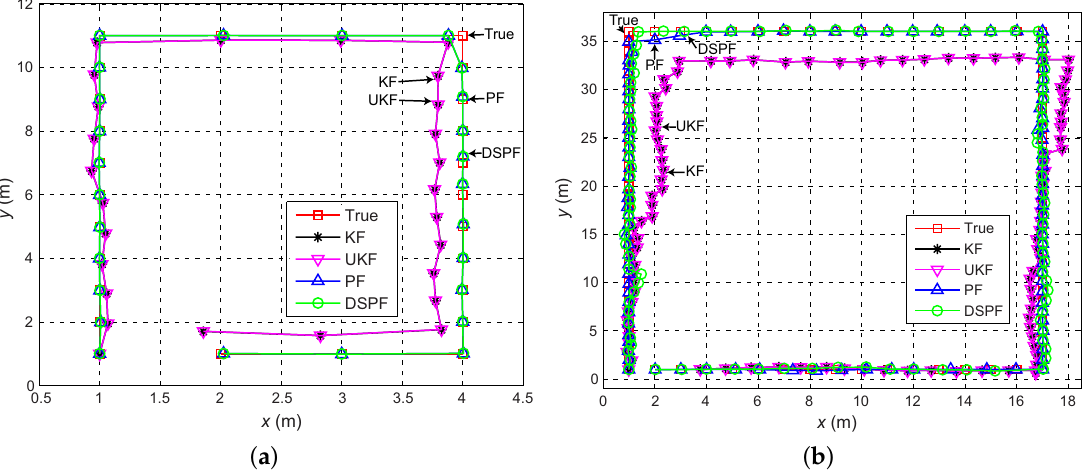
Figure 8. Pedestrian trajectories calculated by the positioning scheme in which the Bayes filters are performed by DRC3 when striding on the physical positions (orange circles and green squares in Figure 4) of test cases ( a ) TC1 and ( b ) TC2 clockwise. The trajectories are indicated with x (east) and y (north)